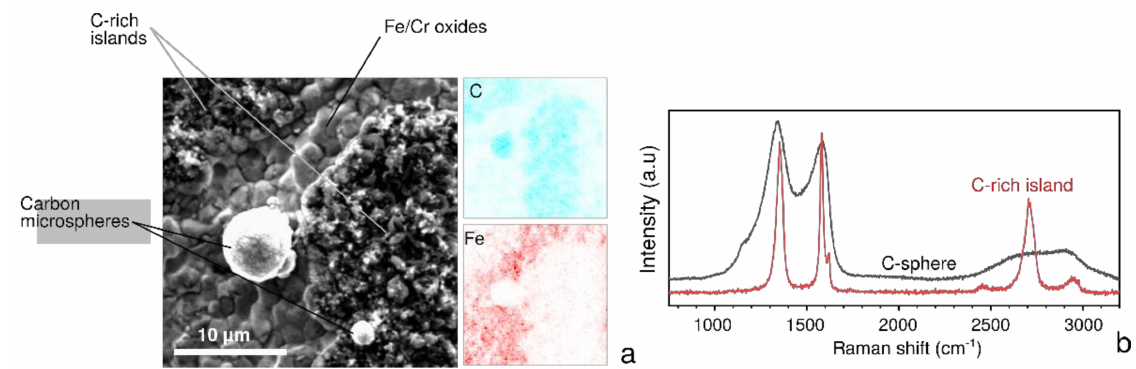
Figure 6. ( a ) SEM micrograph and EDX mapping of the C and Fe elemental composition. ( b ) Raman spectra of the two different C-rich regions identified in the SEM